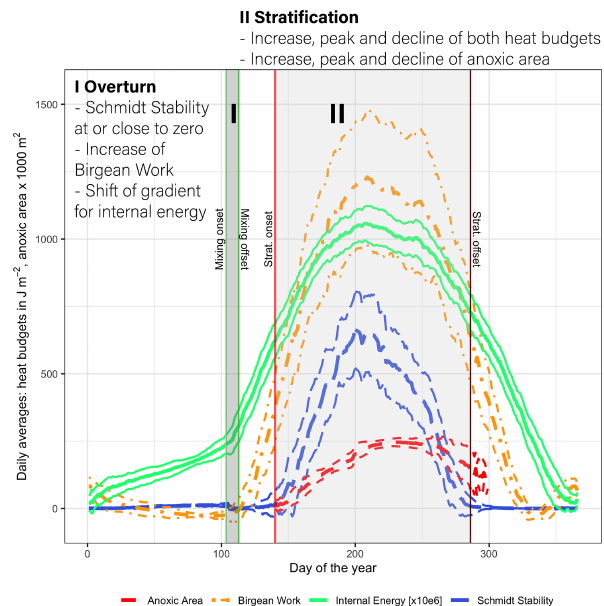
Figure 6. Daily average values of the Schmidt stability, the Birgean work, internal energy, and anoxic area (below 1mgL − 1 ) plus or minus the respective standard deviations (dashed lines) (internal en- ergy is given in 10 6 Jm − 2 ). [Anoxic area units were adjusted for